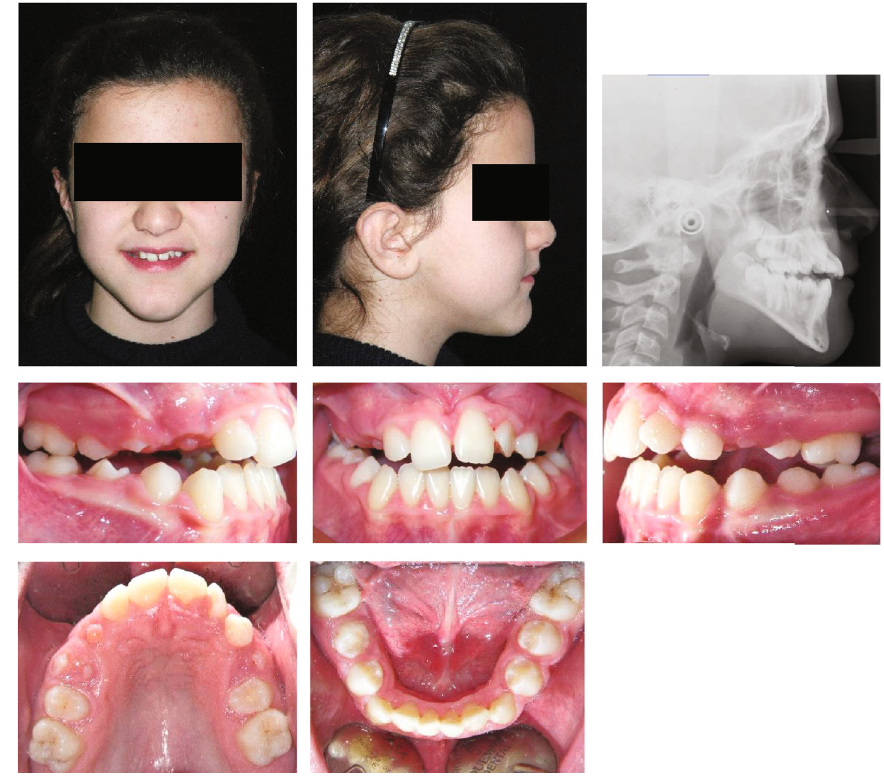
Figure 12: Case no. 2 facial photos, intraoral photos, panoramic radiograph, and lateral cephalogram at T